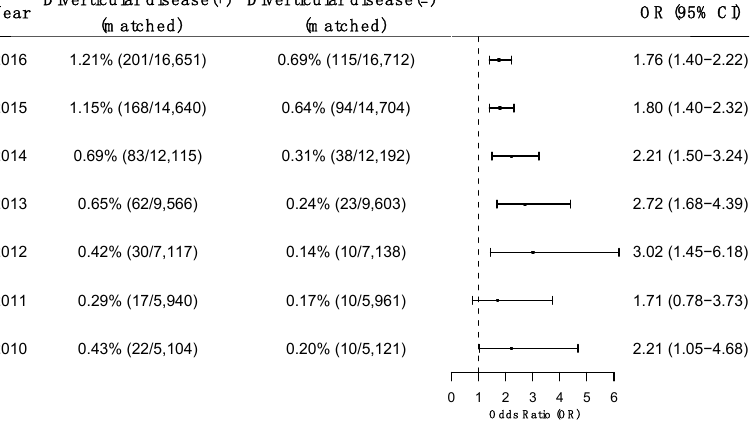
Figure 3. Comparison of 5-year risk of EOCRC in propensity-score-matched Diverticular disease (+) and Diverticular disease (-) cohorts for 7 study populations (age 20–44). Cohorts were propensity- score matched for potential confounders including demographics (age, gender, race, ethnicity), ad- verse socioeconomic determinants of health and lifestyles, comorbidities, and medications. First- time diagnosis of EOCRC was followed for 5 years, for example from 2016 after the diagnosis of diverticular disease through 2021 for the 2016 study population.